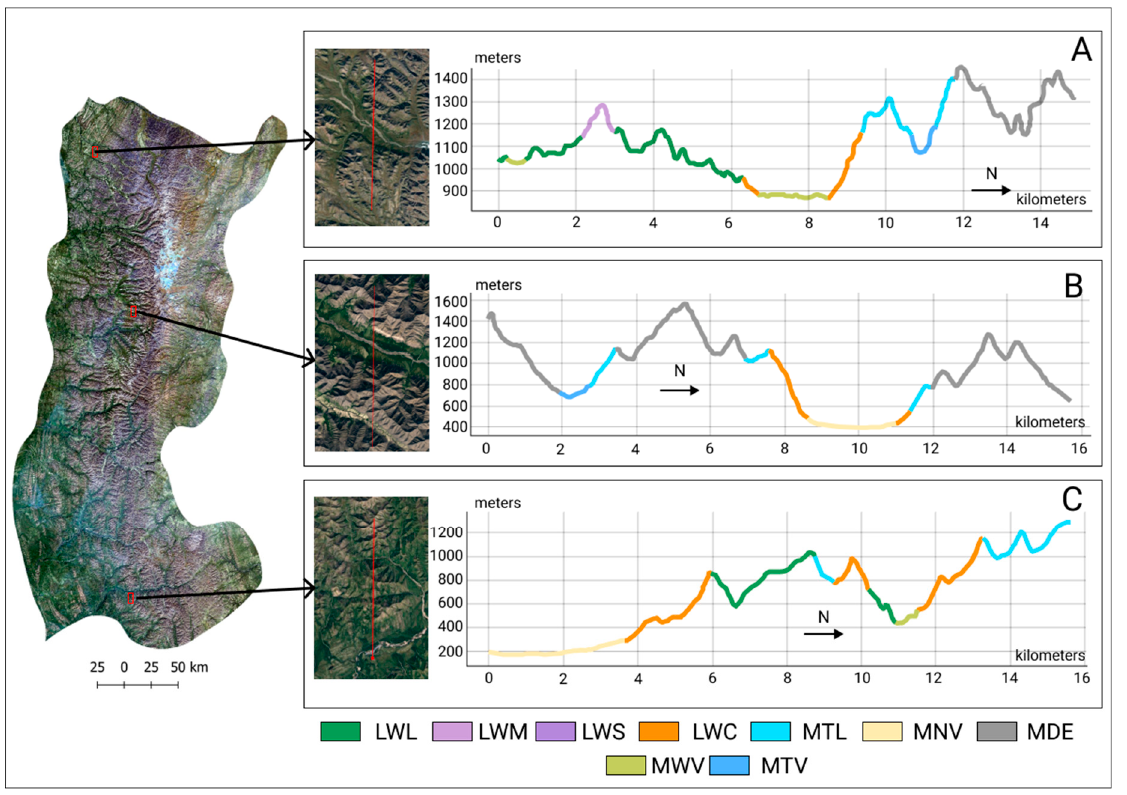
Figure 8. Hypsometric longitudinal landscape profiles on the Orulgan ridge: ( A ) (129 ◦ 16 (cid:48) 46” E), ( B ) (127 ◦ 59 (cid:48) 15.4” E), and ( C ) (126 ◦ 40 (cid:48) 48.6” E). Figure 9 shows latitudinal profiles. Profile D was made at latitude 69 ◦ 08 (cid:48) 00” N with altitude ranging from 497 to 1765 m. This landscape profile clearly demonstrates the longitude sector of the Orulgan ridge. The ridge is divided into two macroslopes: east and west. The eastern macroslope belongs to the Lena River basin, and the western one is to the Yana River basin. In boreal landscapes, LWM prevails. On gentle slopes, LWS are common with very sparse forest and numerous swamps. Profile F was made at latitude 67 ◦ 35 (cid:48) 01.0” N with altitude difference from 594 to 2211 m. Mountain deserts start from a altitude of 1000 m. valleys do not feature intrazonal landscapes. Profile G was made at latitude 66 ◦ 19 (cid:48) 51.0” N with altitude ranging from 594 to 2211 m. The southern profile is very diverse. Almost all classes of landscapes are represented there. The western macrocline is represented by boreal forests; the slopes are mainly covered with LWC. Eastern macroslope forest landscapes are represented by LWM and MTW. Mountain tundras are confined to steep slopes and peaks with a altitude of up to 1200 m. and then give way to mountain